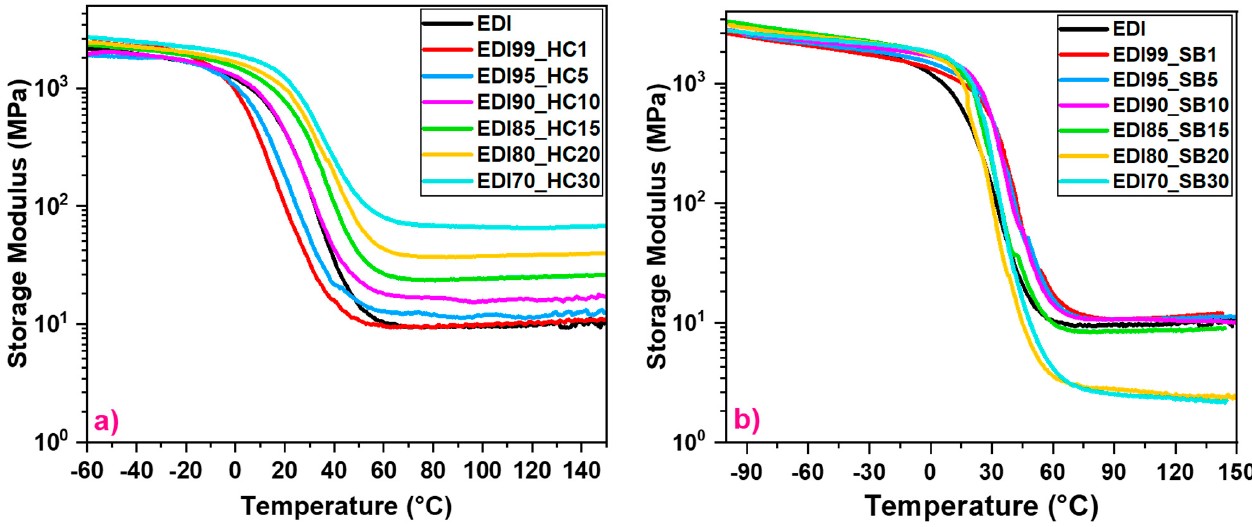
Figure 5. Storage modulus ( E’ ) vs. temperature curves of the ( a ) HC-based samples and ( b ) SB-based samples .